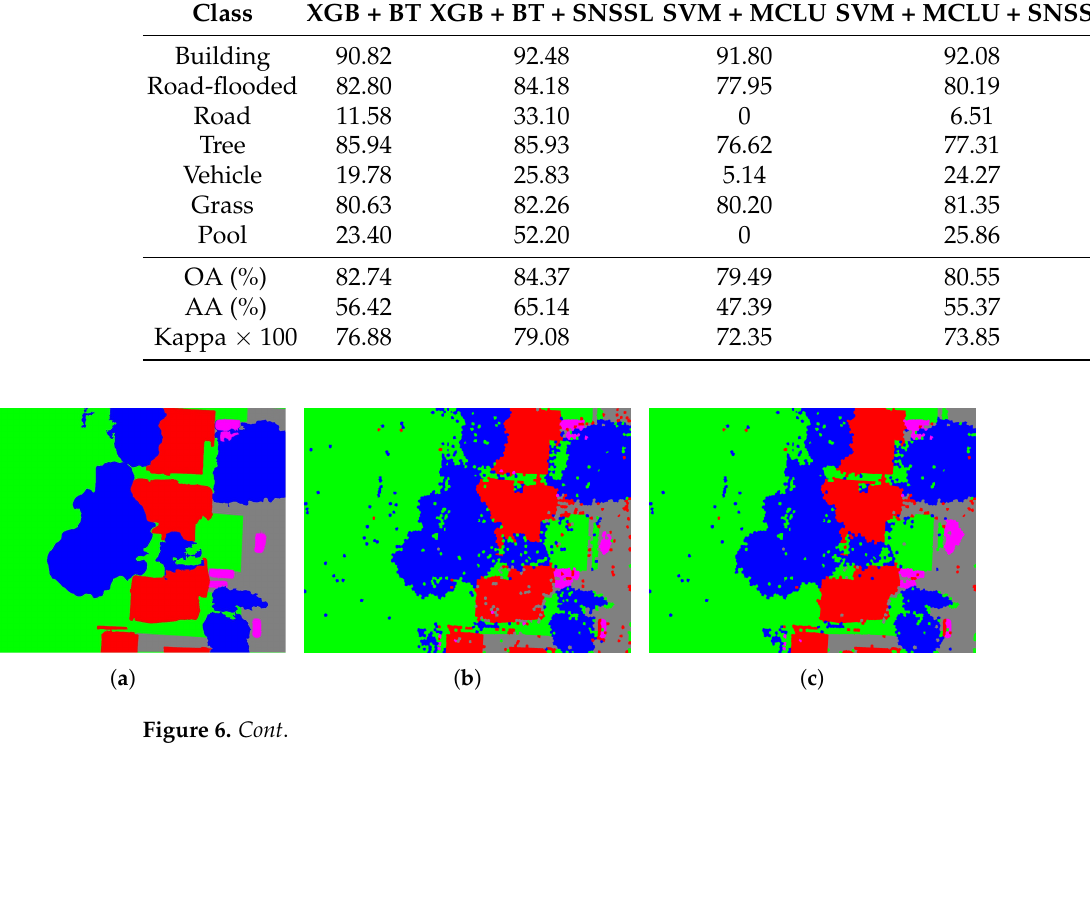
Table 4. Classification accuracy (averaged on 5 runs) of the FloodNet-7577.